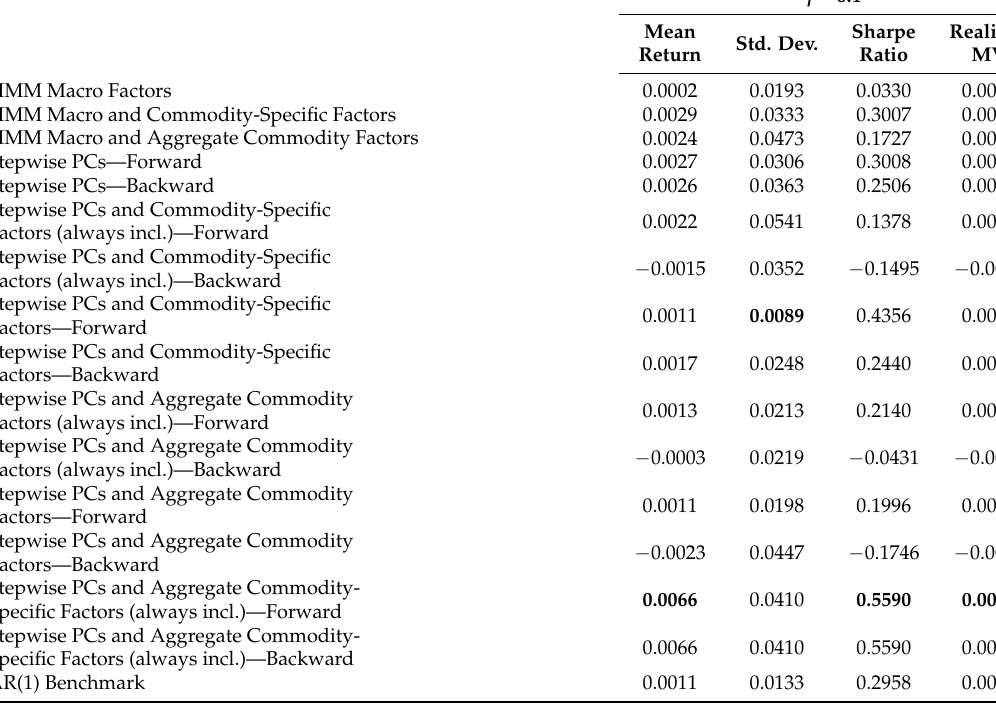
Table 8. Realized portfolio performance of mean-variance strategies based on HMM vs. stepwise regression forecasts (with transaction costs). The table reports the realized OOS performance measures obtained from recursive mean-variance portfolio optimization strategies over a January 2004–May 2018 sample. The 16 models reported are obtained as three HMMs with regimes plus the best 12 stepwise predictive regressions selected on the basis of their RMSFE, and the AR(1) benchmark. Transaction costs are not only imputed ex post as a function of the portfolio trades executed, but also ex ante in the sense that only monthly portfolio changes that are expected ex ante to increase mean-variance utility in excess of the loss caused by the transaction costs are executed. We boldface the highest realized performances. γ =